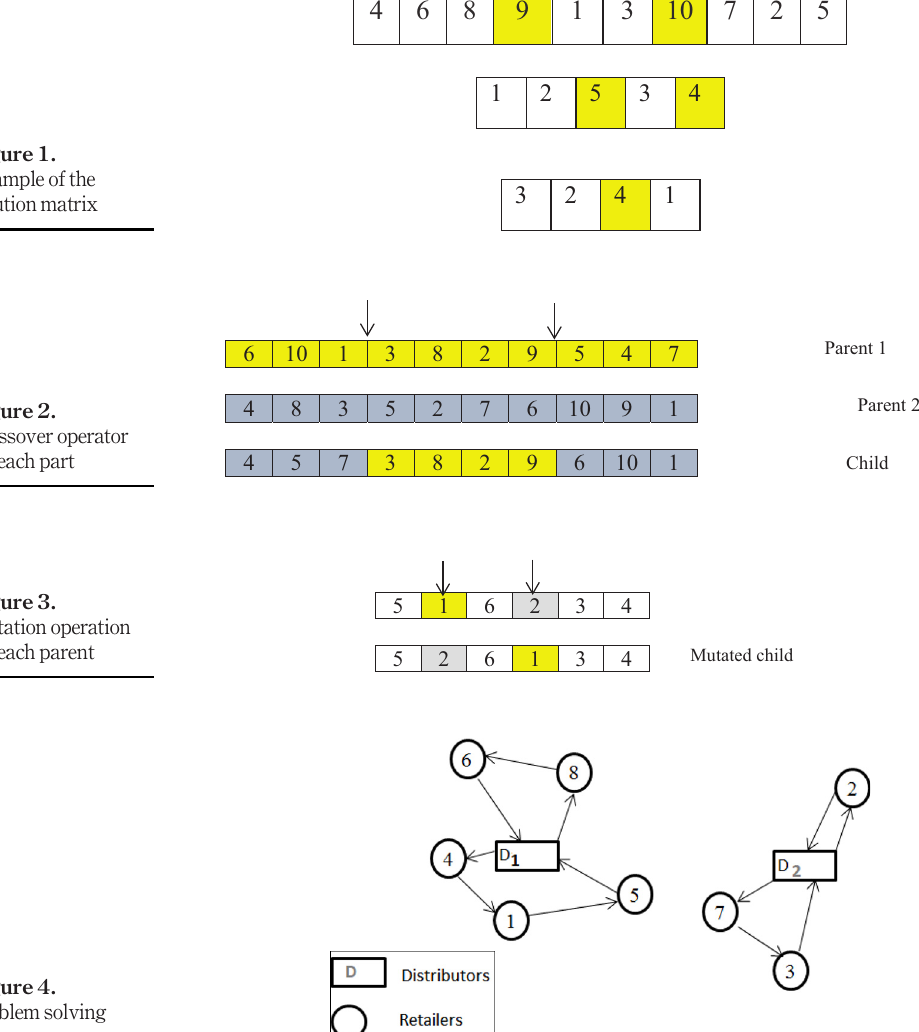
Figure 1. Example of the solution matrix